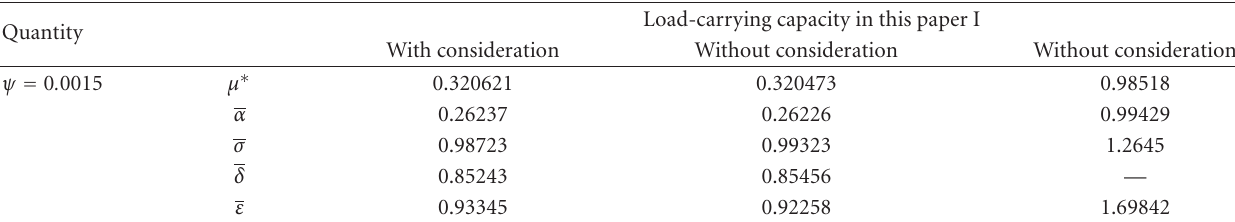
Load-carrying capacity in this paper I Quantity With consideration Without consideration Without